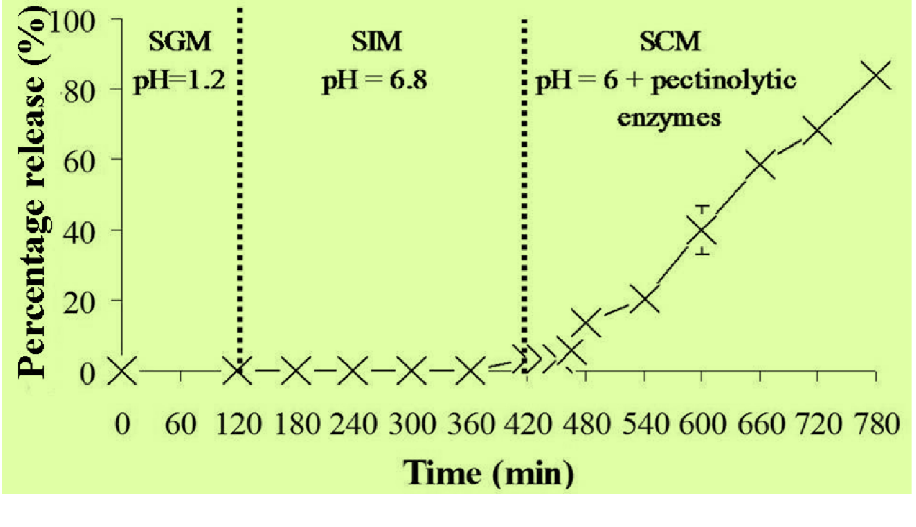
Figure 5. Release profile of MSKE from ZPG 2% beads in enteric-coated capsules determined under conditions mimicking the gastro-intestinal tract (pH 1.2 then pH 6.8) to the colon (pH 6 with pectinolytic enzymes). Data are presented as the mean ± SD of three determinations.